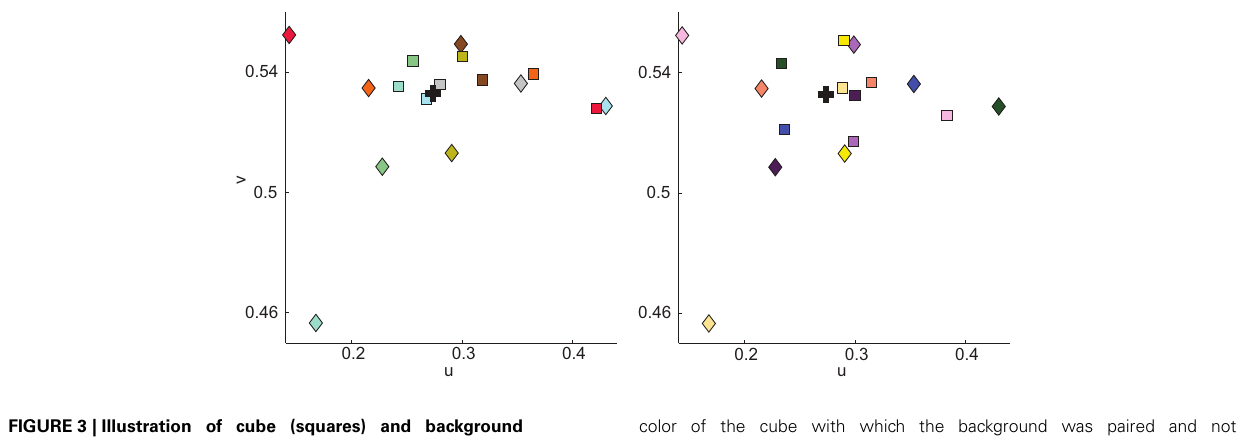
color of the cube with which the background was paired and not the apparent color of the background. Color specifications for cubes and backgrounds are in Table 2 . Black + indicate illuminant